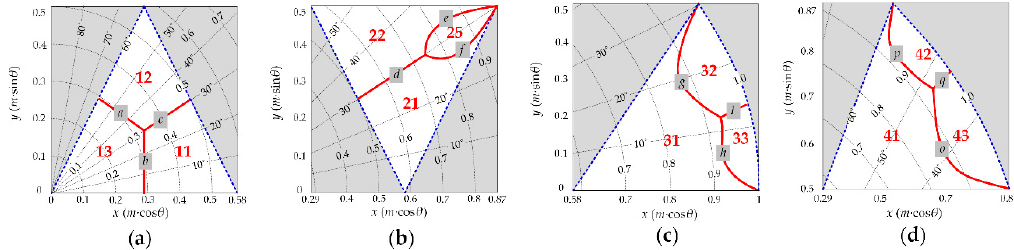
Figure 5. The optimal distribution of sub-regions for different switching sequences in Sector Z 1 : ( a ) Triangle ① ; ( b ) Triangle ② ; ( c ) Triangle ③ ; ( d ) Triangle ④ .